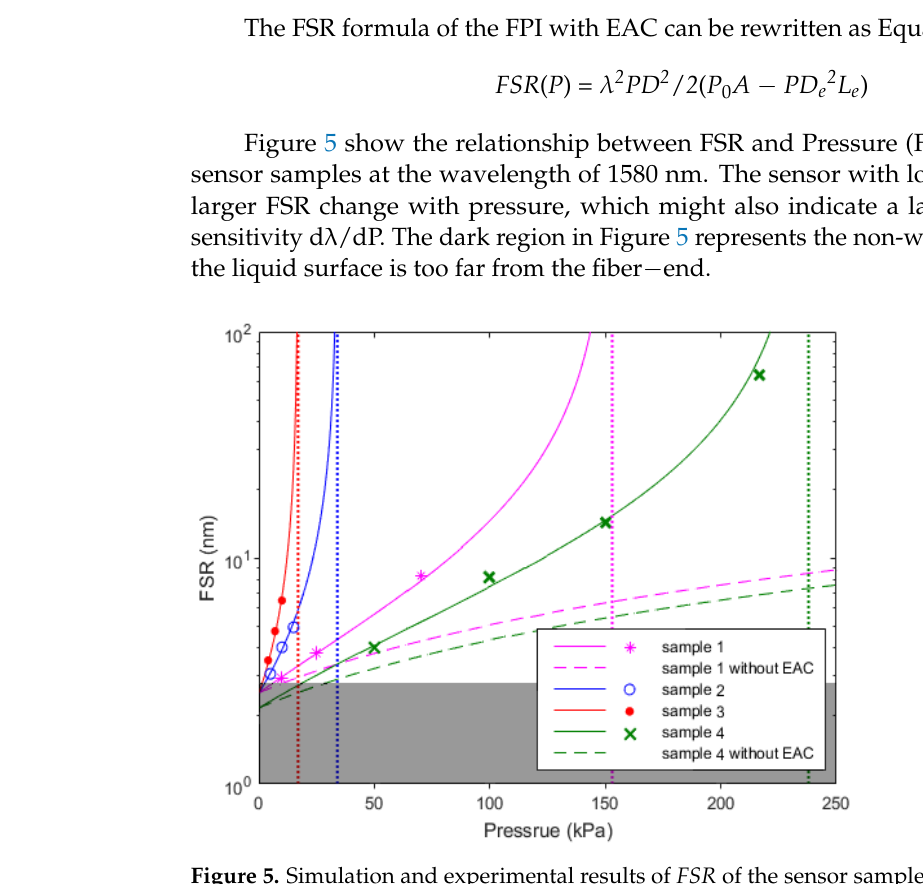
Figure 5. Simulation and experimental results of FSR of the sensor samples.